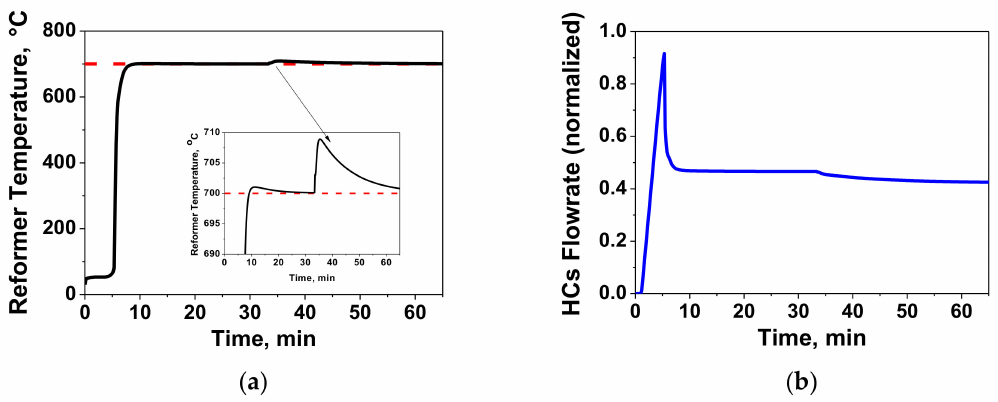
Figure 8. ( a ) Temperature profile of the reformer (TC1 controller) and ( b ) HCs flowrate manipulation at the combustor.